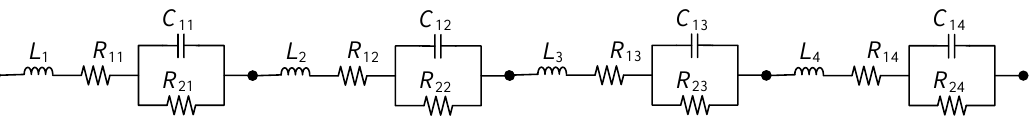
Figure 9. An extracted equivalent circuit of an air-core reactor. Table 1. Circuit parameters determined by the vector fitting approach.